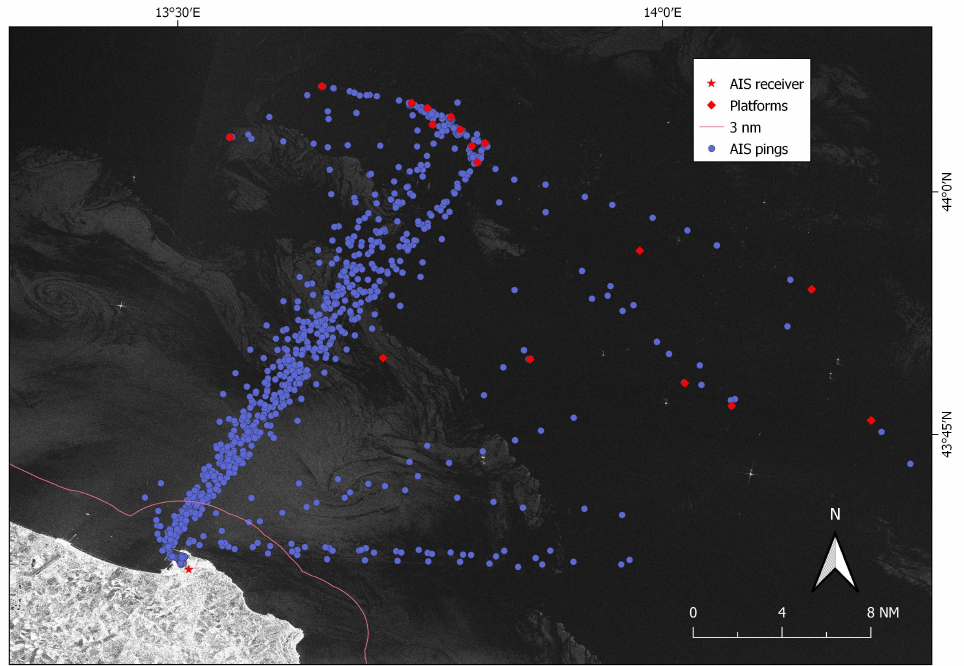
Figure 11. Sentinel-1 image taken on 19 July 2019 (VV channel) and AIS signals (purple points) broadcasted by a platform supply vessel during July